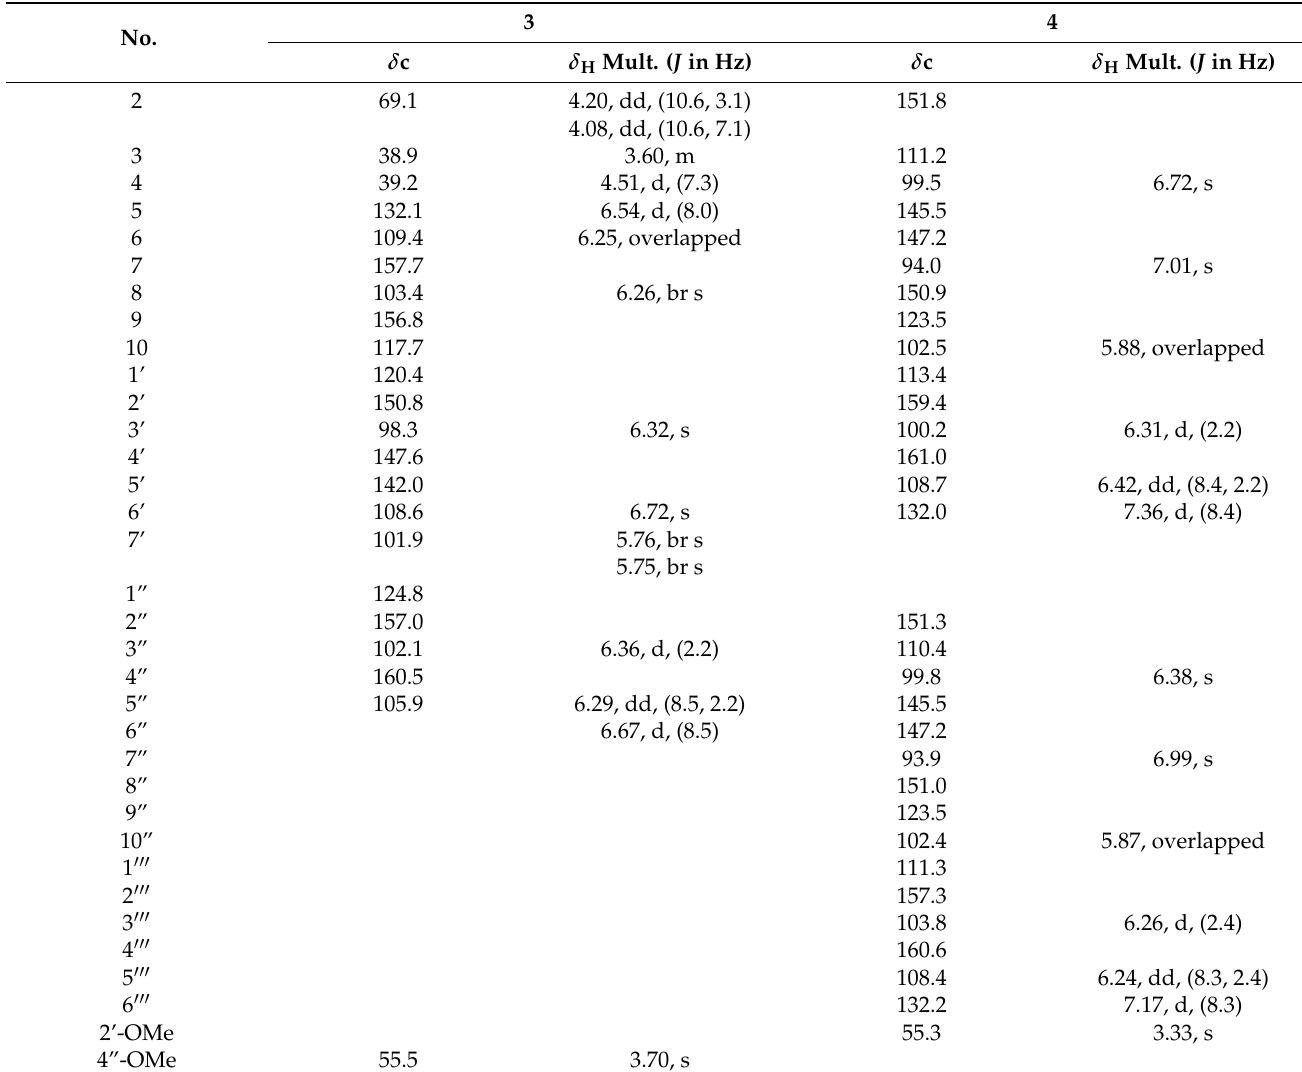
Table 2. 1 H and 13 C NMR data of compounds 3 and 4 ( δ H in ppm, J in Hz).